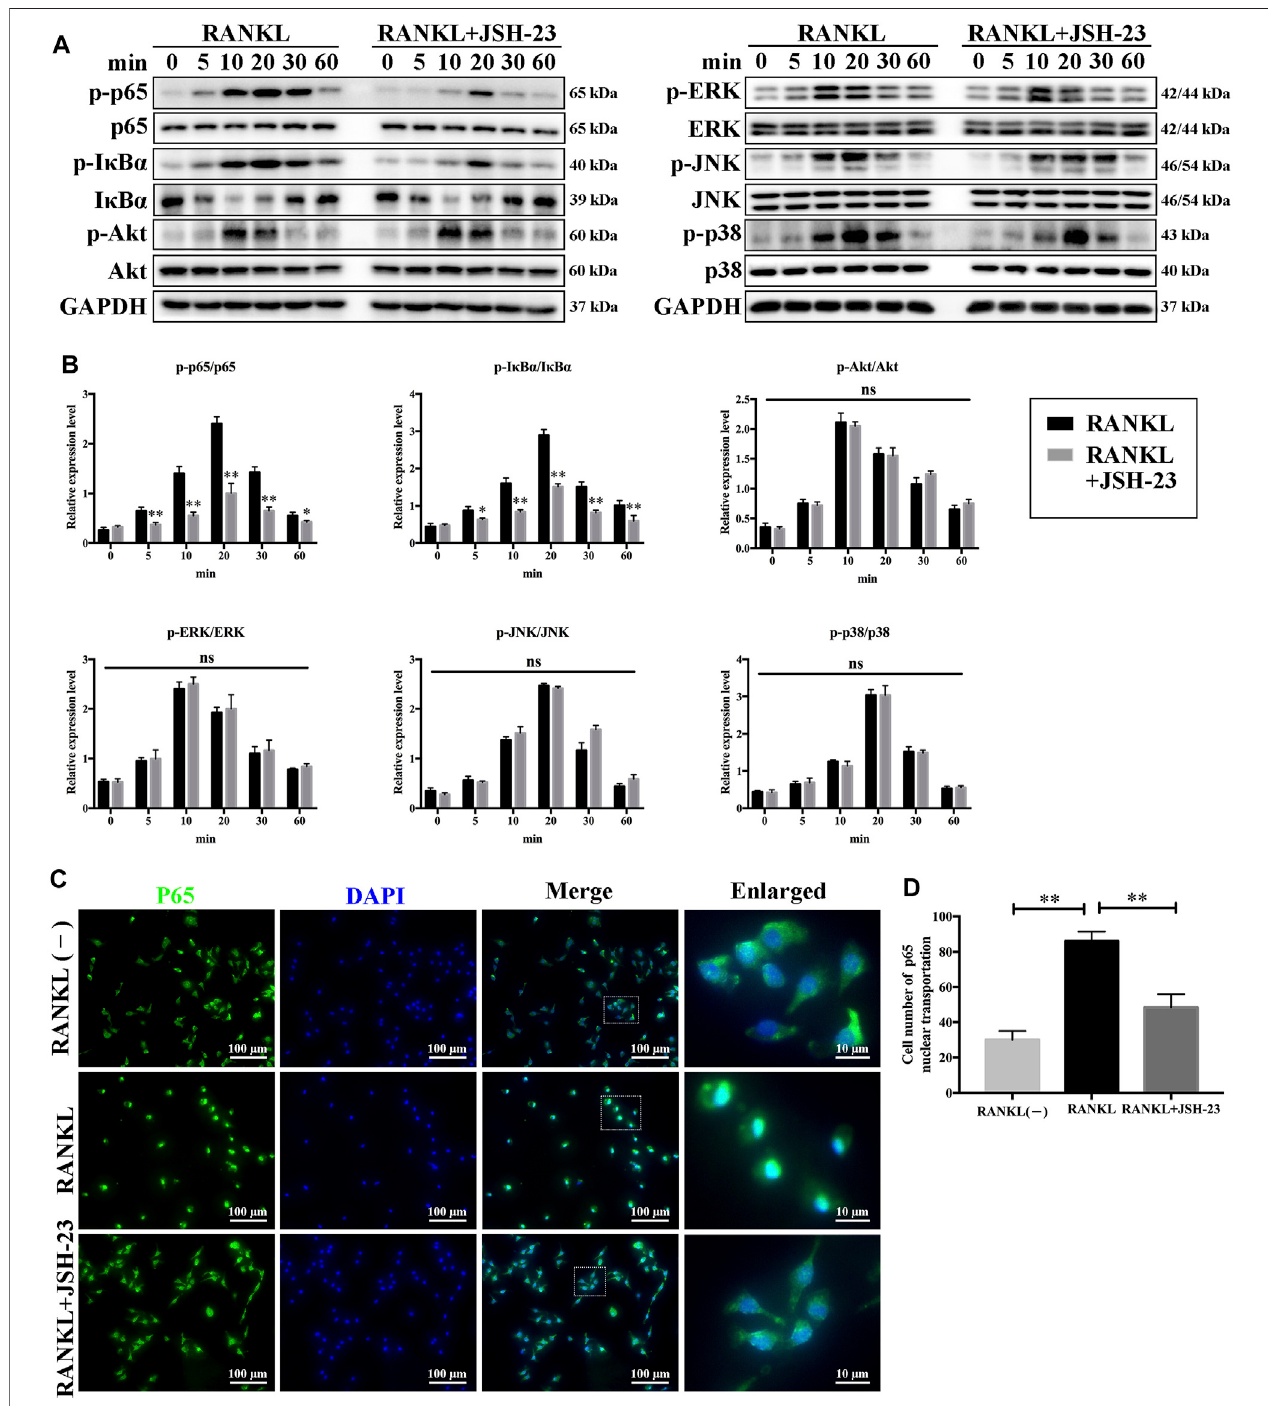
FIGURE 3 | JSH-23 suppresses osteoclastogenesis via inhibition of the NF- κ B signaling pathway. (A) BMMs were pretreated with JSH-23 (40 μ M) for 4 h and thereafterexposedtoRANKL(100 ng/ml)fortheindicatedtimes (0,5,10,20,30and60 min).TheactivationoftheNF- κ B,MAPKandPI3K/Aktsignalingpathwayswas examined by western blotting analysis and (B) quanti fi ed accordingly. (C) BMMs were pretreated with JSH-23 for 4 h and then stimulated with RANKL for 30 min. The representative immuno fl uorescence images show that recombinant JSH-23 treatment inhibited p65 nuclear transportation. (D) Quantitative analysis of cells with p65 nuclear translocation using ImageJ. The values are shown as the means ± SDs, n (cid:1) 3; ns, no signi fi cance; * p < 0.05, ** p < 0.01.